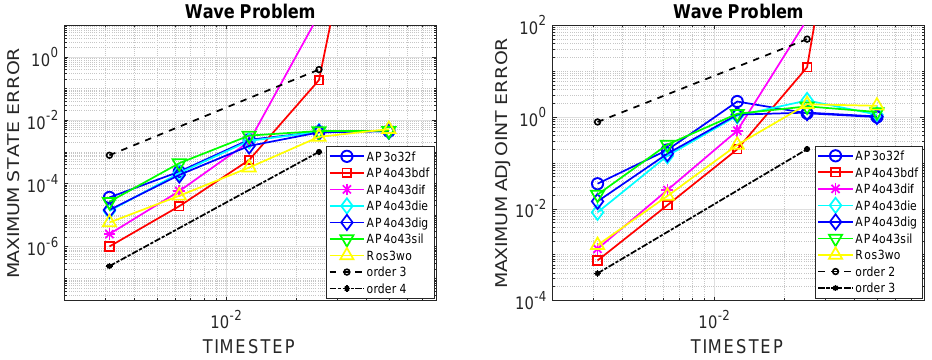
Figure 4. Wave Problem: Convergence of the maximal state errors (cid:107) ( w T ⊗ I ) Y n − y ( t n + 1 ) (cid:107) ∞ ( left ) and adjoint errors (cid:107) ( v T ⊗ I ) P n − p ( t n ) (cid:107) ∞ ( right ), n = 0, . . . , N